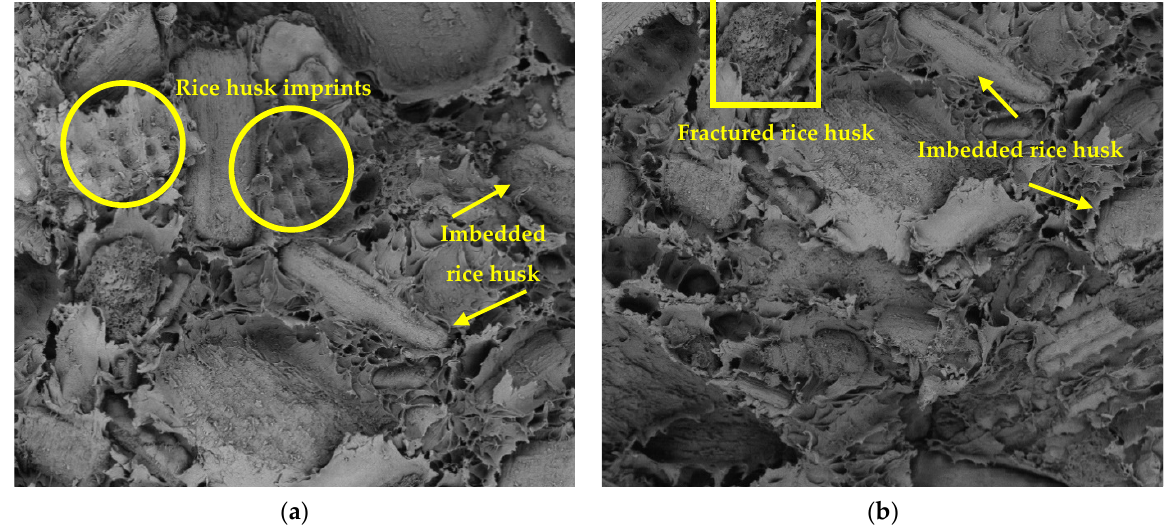
Figure 9. SEM micrographs for reinforced composite rHDPE/RH 2 ( a ) 200× and ( b ) 180× magnification.